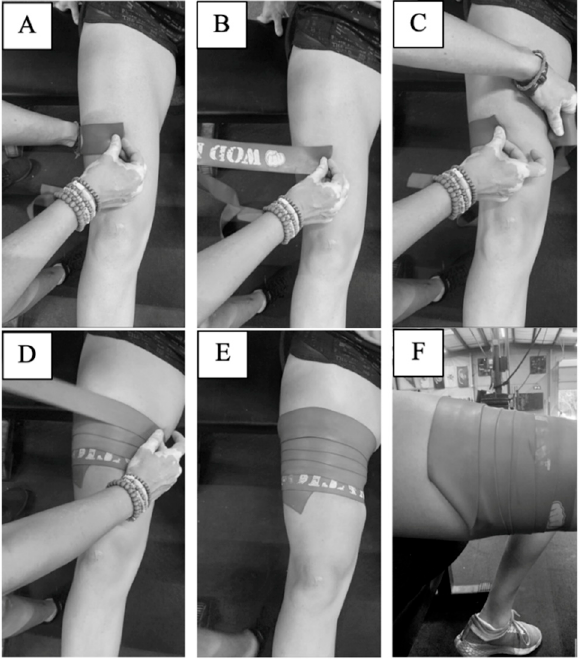
Figure 1. BTF BFR wrapping protocol. ( A ): Starting 1/3 of the thigh length from the top of the patella, measure the band to ½ the participant’s thigh circumference. ( B ): Marking that distance with the thumb, lift the band off the participant’s skin and stretch the band. ( C ): Stretch that distance of the band around ¾ of the participant’s thigh circumference and apply pressure to keep in place. ( D , E ): Continue this process, with each layer overlapping the previous by ½ the width of the band. ( F ): Tuck the loose end under the layer prior.